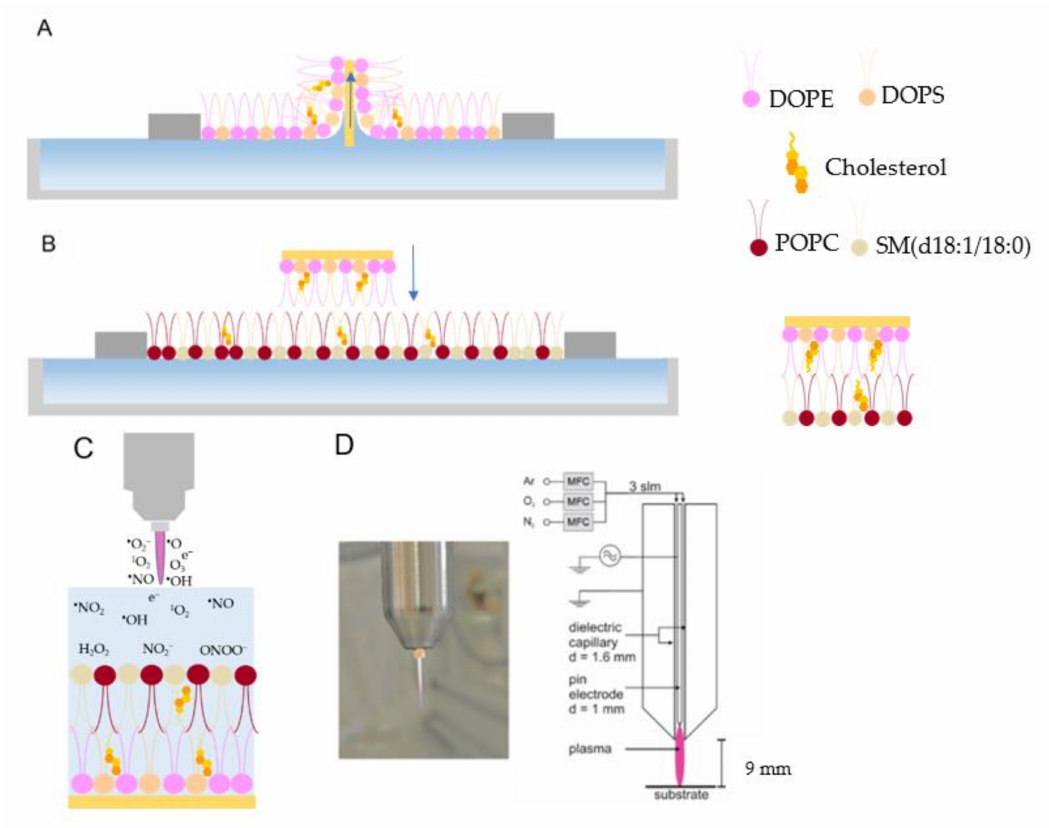
Figure 1. ( A ) Langmuir-Blodgett deposition of the first monolayer (inner leaflet) and ( B ) Langmuir- Schaefer deposition of the second monolayer (outer leaflet) on the surface of the gold to prepare an asymmetric supported lipid bilayer. ( C ) Schematic of the treatment of the supported lipid bilayer by cold physical plasma. ( D ) Image and schematic of the plasma jet kINPen used in this study. DOPE: 1,2-dioleoyl-sn-glycero-3-phosphoethanolamine, DOPS: